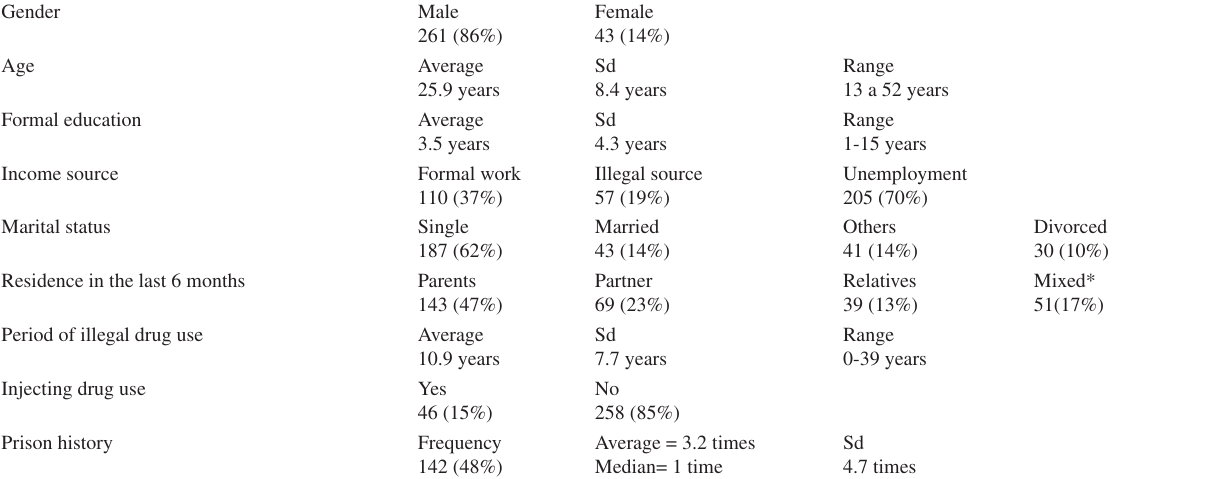
Table 1 - Demographic and social characteristics of a sample of 304 drug users under treatment from public health services